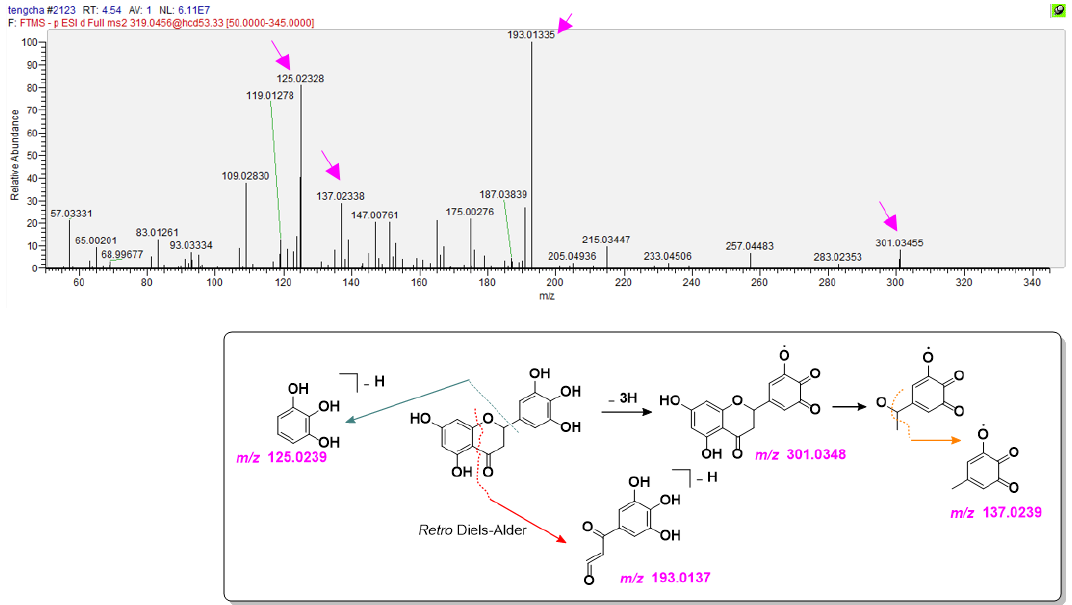
Figure 5. The typical MS/MS spectra of R.T. 4.54 min peak from the lyophilized aqueous extract of vine tea ( upper ) and the proposed ampelopsin elucidation ( below ). The m/z values in purple are the calculated ones. The m/z calculation was based on the relative atomic masses of C (12.0000), H (1.007825), O (15.994915), and N (14.003074).